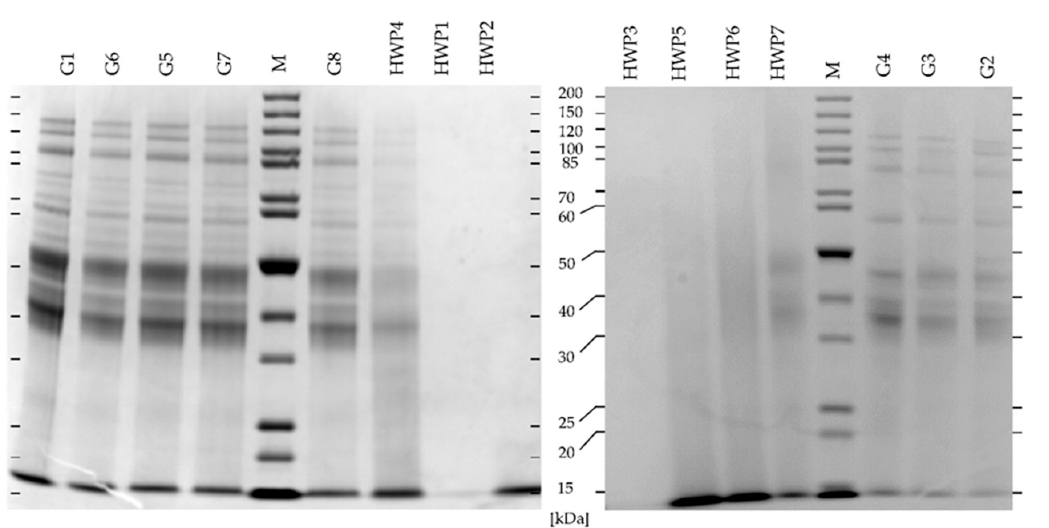
Figure 3. Sodium dodecyl sulfate-polyacrylamide gel electrophoresis of gluten samples (G1–G8) and hydrolyzed wheat proteins (HWP1–HWP7). Protein marker 3.5 µg, samples 15 µg.